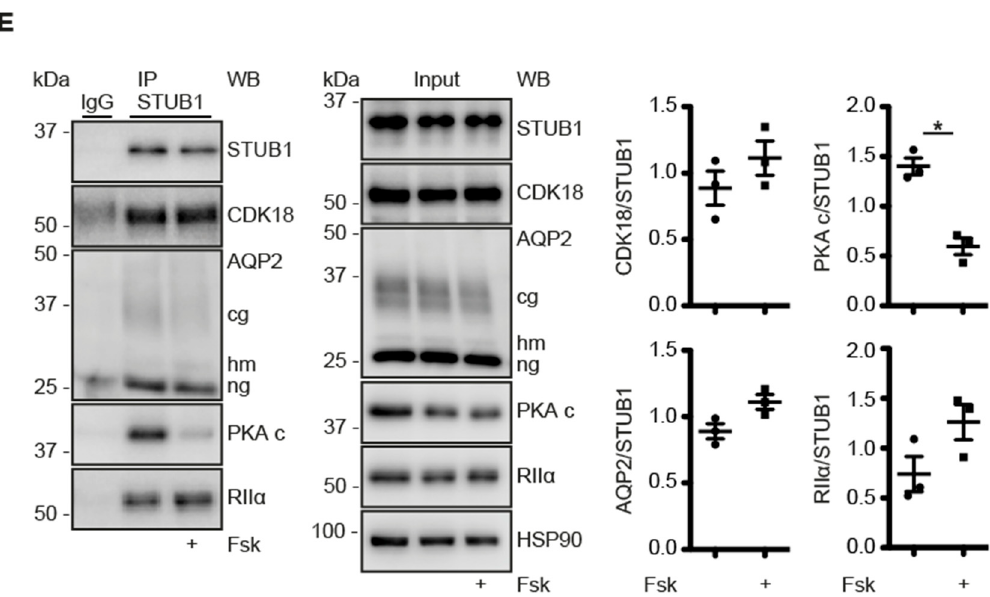
Figure 5. STUB1 organizes a signalosome comprising CDK18, AQP2 and PKA and functions as an A-kinase anchoring protein (AKAP). ( A ) MCD4 cells were lysed and the lysates incubated with the peptide Ht31, which inhibits AKAP-PKA interactions, the inactive peptide Ht31-PP or vehicle and subjected to cAMP-agarose pull down (PD). As negative control, the pull down samples (PD) were incubated with an excess of cAMP. The indicated proteins in the pull down and input samples were detected by Western blotting and the signals were densitometrically evaluated. Shown are representative results from n = 4 independent experiments. ( B ) MCD4 cells were transfected with siRNA against STUB1 or control non-targeting (siNT) and subjected to cAMP-agarose pull down. As a control, the precipitates (PD) were incubated with an excess of cAMP. The indicated proteins were detected by Western blotting and the signals densitometrically evaluated shown are representative results from n = 5 independent experiments. ( C ) MCD4 were lysed and the lysates were left untreated, incubated with the peptide Ht31 or PP-Ht31. STUB1 was immunoprecipitated (IP). As control, precipitations were carried out with unrelated IgG. The indicated proteins in the precipitates and input samples were analyzed by Western blotting. HSP90 served as a loading control. Shown are representative results from n = 4 independent experiments. The signals were semi-quantitatively analysed by densitometry. ( D ) Murine STUB1 was spot-synthesized as 20-mer peptides with 5 residues offset. Spots 1–5 cover amino acids (Aa) 150–190. The spots were incubated with P 32 -labeled recombinant human RII α subunits of PKA in the absence or presence of the peptide L314E, which inhibits AKAP-PKA interactions. A representative overlay from n = 4 independent experiments is shown. The semi-quantitative densitometric analysis is shown. ( E ) MCD4 cells were left untreated or stimulated with forskolin (Fsk) and STUB1 was immunoprecipitated. As a control, unrelated IgG (IgG) was used. The indicated proteins in the precipitates and the input samples were detected by Western blotting. Shown are representative results from n = 3 independent experiments. The signals were semi-quantitatively analyzed by densitometry. cg: complex glycosylated, hm: high-mannose, ng: non-glycosylated AQP2. Statistically significant differences are indicated, * p < 0.05, ** p < 0.01, **** p < 0.0001.